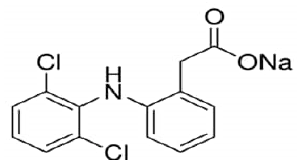
Figure 1. Sodium (2[(2, 6-diclorophenyl) amino] phenyl acetate)